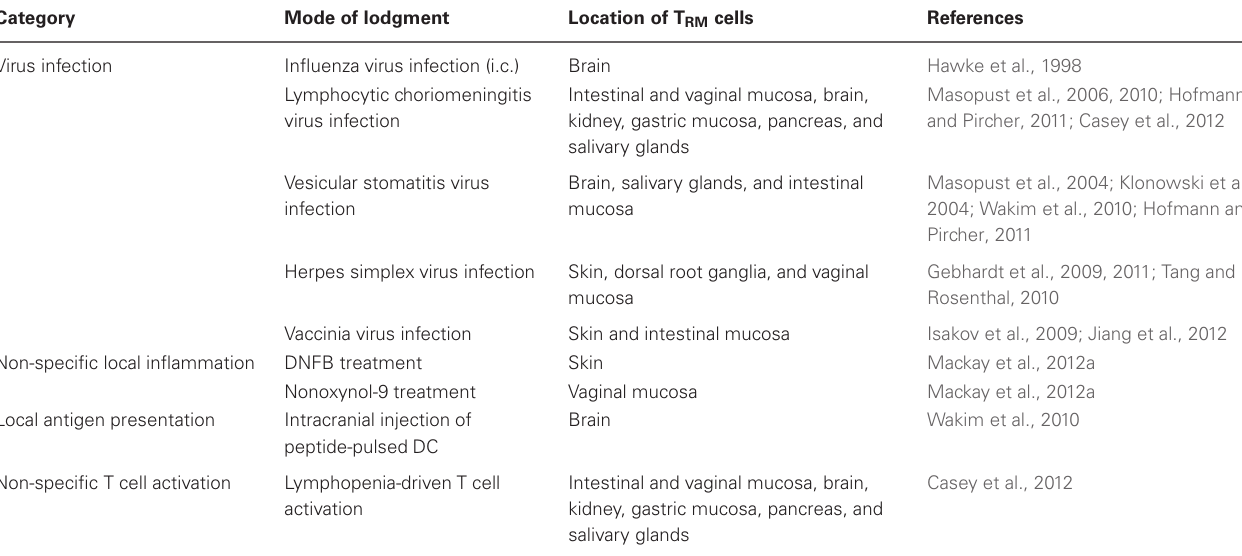
Table 1 | Examples of mouse models describing peripheral CD8 + memory T cells that fit the recent definition of CD103 + T RM cells.